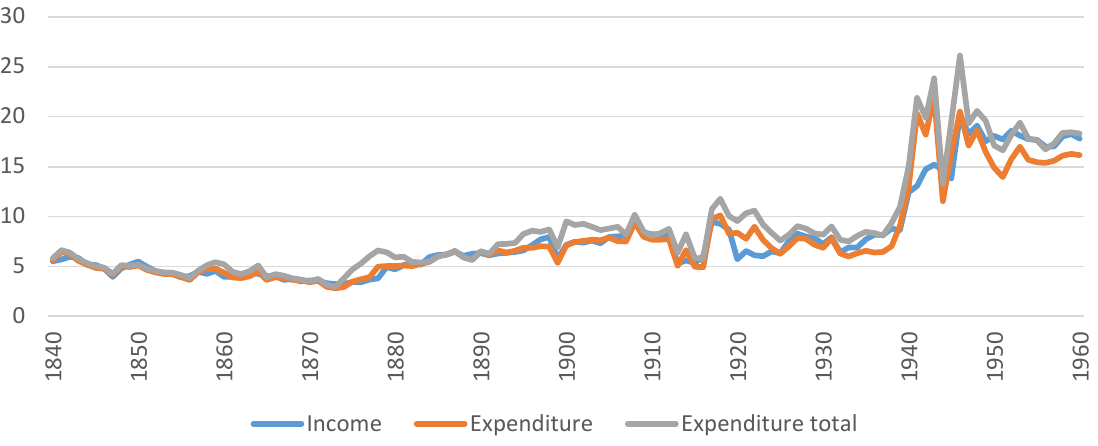
Figure 3. Central government sector income and spending in percent of GDP, 1840–1960